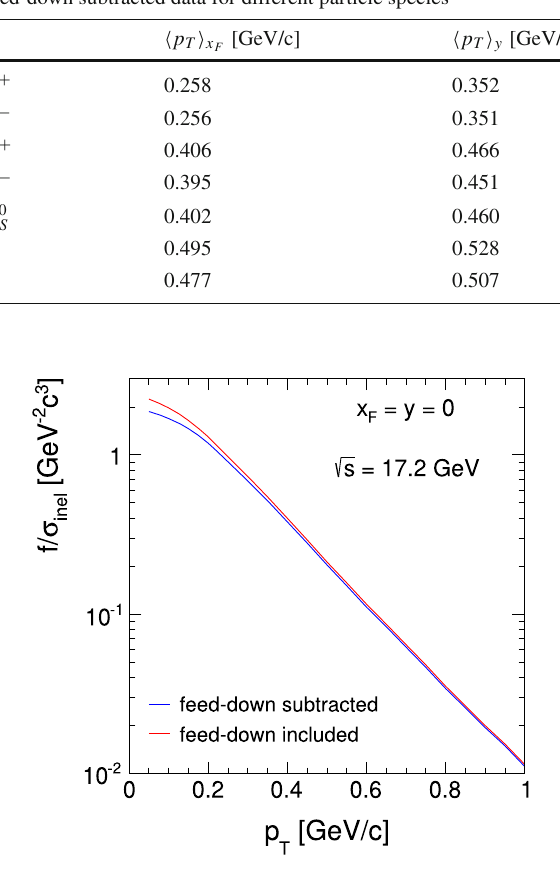
Fig. 139 f /σ inel for π − as a function of p T at x F = y = 0 with and without feed-down subtraction